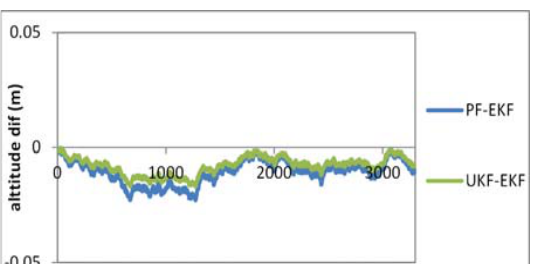
Figure 3. Positioning errors comparison.